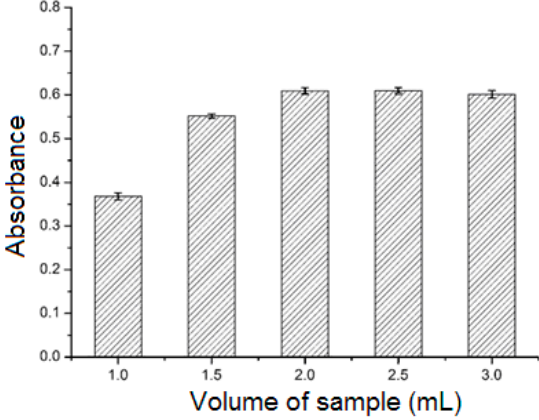
Figure 5. Effect of sample solution volume. Analyte concentration: 3.0 mmol L − 1 ; elution solvent: methanol (4 mL).